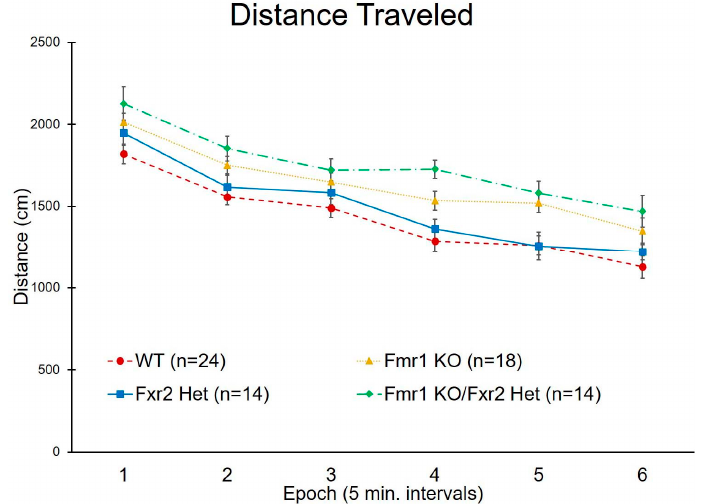
Figure 2. Distance traveled in the open field across the 30 min testing period. We found a statistically significant main effect of genotype ( p < 0.001). Both Fmr1 KO and Fmr1 KO/ Fxr2 Het mice were statistically significantly hyperactive compared to WT ( p = 0.017 and p < 0.001, respectively). Additionally, Fmr1 KO/ Fxr2 Het mice were more active than Fxr2 Het mice ( p = 0.025). Each point represents the mean ± SEM for the number of mice indicated on the figure. Table 1. Results of repeated measures ANOVA for behavior testing with corresponding F-values and p -values. *, p < 0.05. ~, 0.05 ≤ p ≤ 0.10.